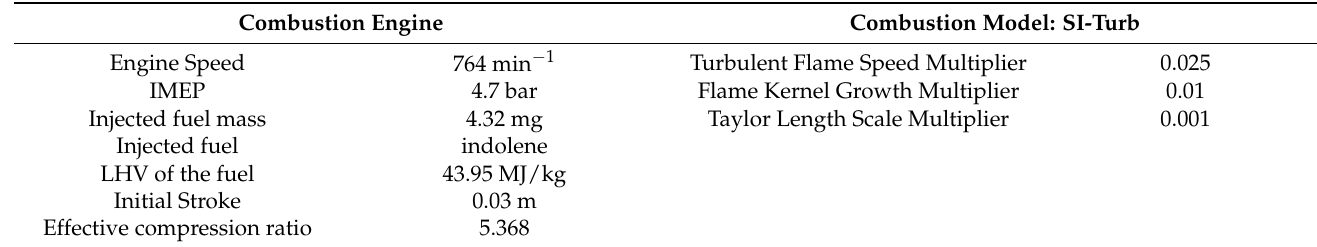
Table 3. Boundary conditions of the thermodynamic